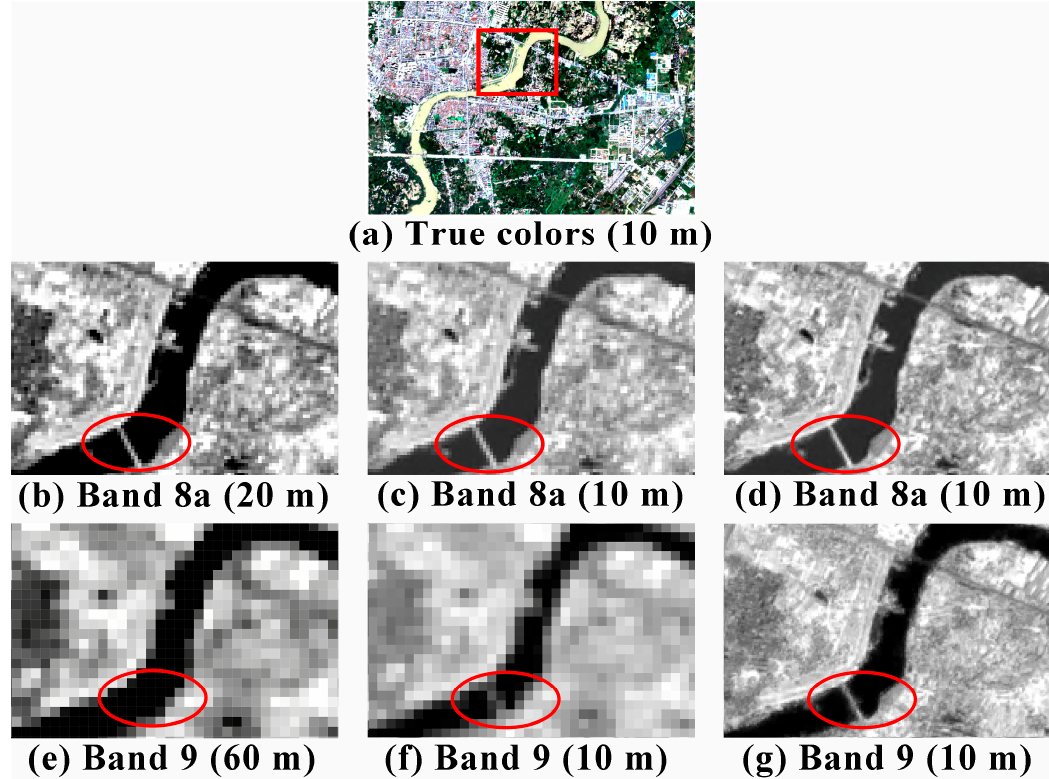
Figure 4. Comparison of the enhanced image and original image. ( a ) RGB true-color image, R / G / B = Band4 / Band3 / Band2; ( b ) Band 8a (20 m) of the original image; ( c ) Band 8a (10 m) of the resampling image by nearest neighbor method; ( d ) Band 8a (10 m) of the enhanced image by super-resolution algorithm; ( e ) Band 9 (60 m) of the original image; ( f ) Band 9 (10 m) of the resampling image by nearest neighbor method; ( g ) Band 9 (10 m) of the enhanced image by super-resolution algorithm.